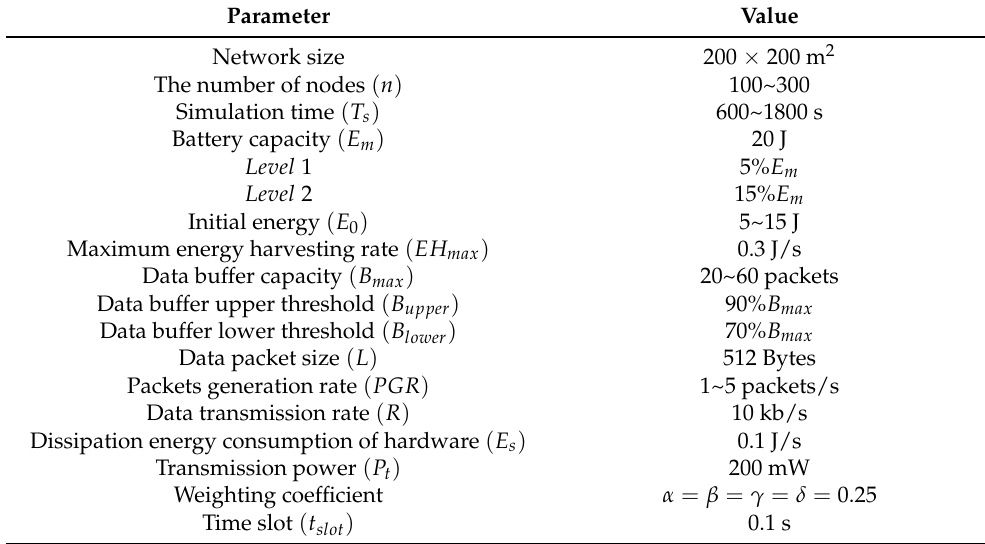
Table 2. Parameters